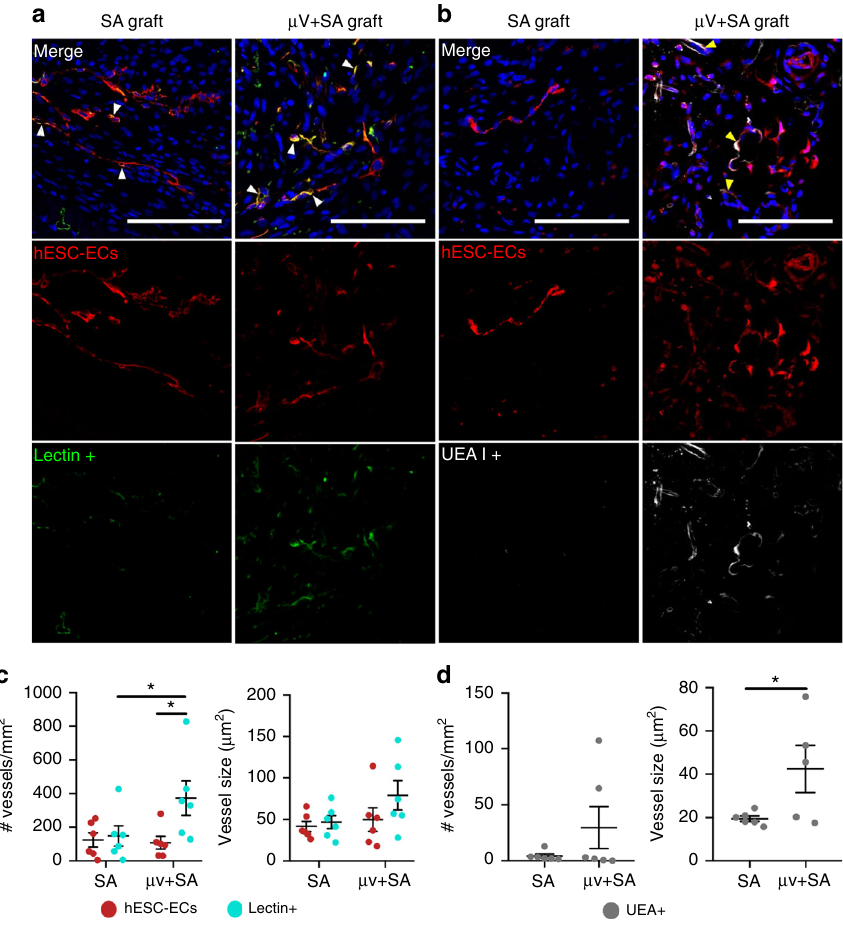
Fig. 6 Detection of human endothelial cells and perfused vessels in grafts 5 days post-implantation. a , b Immuno fl uorescent-stained paraf fi n sections of self-assembled (SA) and µ V + SA grafts: a human embryonic stem cell-derived endothelial cells (hESC-ECs) (DsRed + , red) and perfused rat and human endothelium (Lectin + , green). White arrows in merged images denote double positive cells. Scale bar, 100 μ m. b hESC-ECs (DsRed + , red) and perfused human endothelium (UEA I + , white). Yellow arrows in merged images denote double positive cells. Scale bar, 100 μ m. c Quanti fi cation of vessel density (number of vessels per mm 2 ) and average vessel size for hESC-EC vessels (DsRed + , red circles) and all perfused vessels (Lectin + , blue circles) in the grafts. N = 6 biologically independent animals for both SA and µ V + SA grafts. p = 0.045 for lectin + vessels for SA and µ V + SA, p = 0.018 for DsRed + and lectin + for µ V + SA, p > 0.05 for all others (two-tailed t test). d Quanti fi cation of vessel density and average vessel size of perfused human vessels (UEA I + , grey circles) in the grafts. N = 6 biologically independent animals for both SA and µ V + SA grafts, with one animal with µ V + SA graft excluded from vessel size calculation due to lack of UEA I + vessels. p = 0.023 for vessel size for SA and µ V + SA, p > 0.05 for vessel density (two-tailed t test). Representative images for a , b from six biologically independent animals containing SA grafts and six biologically independent animals containing μ V + SA grafts, with similar results. Hoechst-stained nuclei, blue. Data were collected from at least three confocal images of randomly selected regions per sample and analyzed by a custom lumen identifying code for vessel density and size. Error bars, mean ± SEM. * p < 0.05 determined using two-tailed t test. UEA Ulex